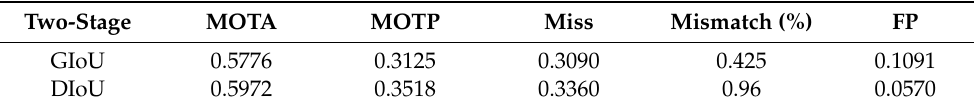
Table 5. Comparisons for 3D MOT two-stage association on pedestrian class, Waymo Open Dataset validation set.